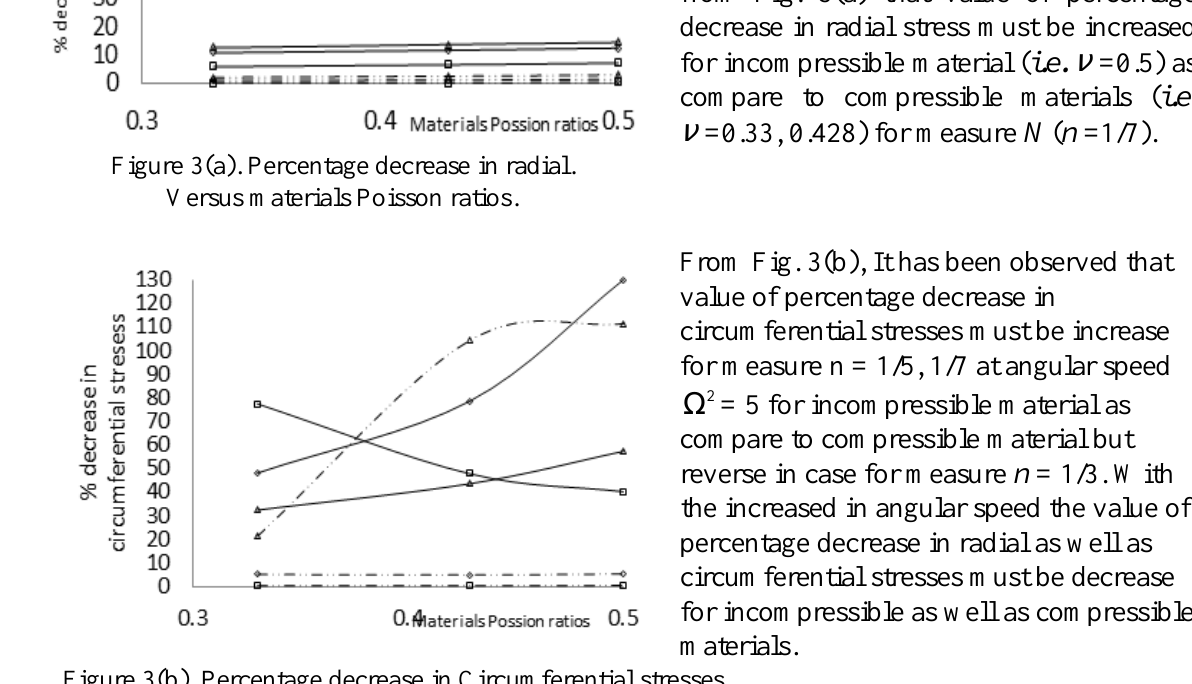
Figure 3(b). Percentage decrease in Circumferential stresses. Versus materials Poisson